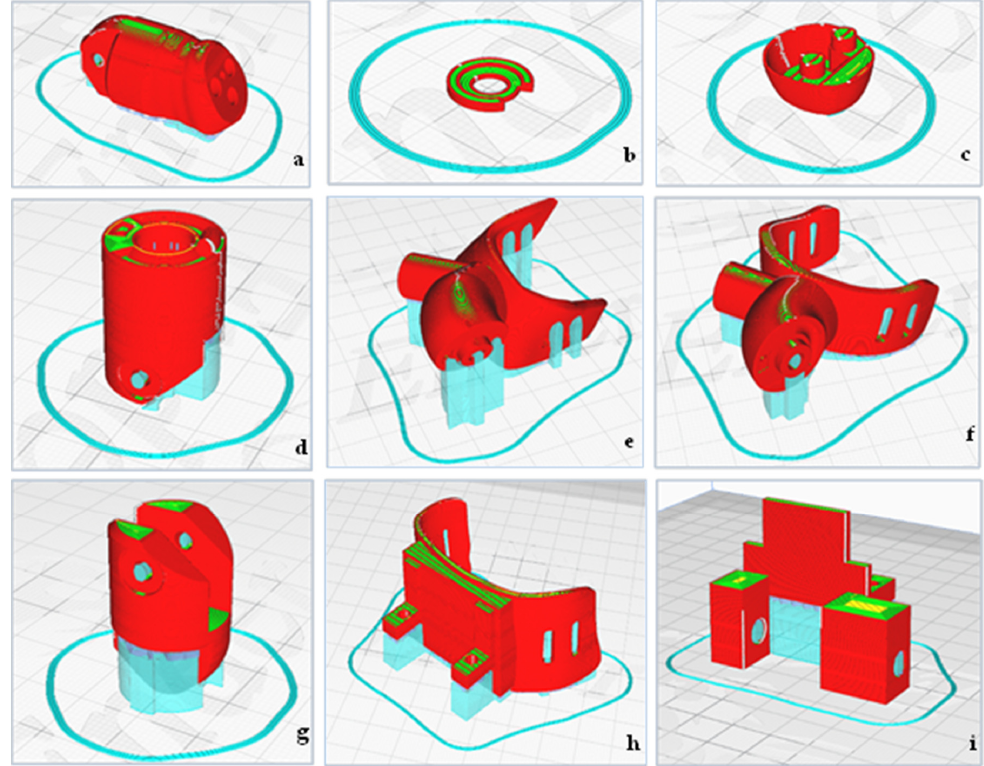
Figure 8. Printing orientations of the parts of the third thumb: ( a ) end phalanx, ( b ) bearing cap, ( c ) end phalanx cap, ( d ) base phalanx, I hand holder for the outer side (between small finger and wrist), ( f ) hand holder for the inner side (between thumb and wrist), ( g ) intermediate phalanx, ( h ) wrist holder for servo motor, ( i ) housing for servo motor.